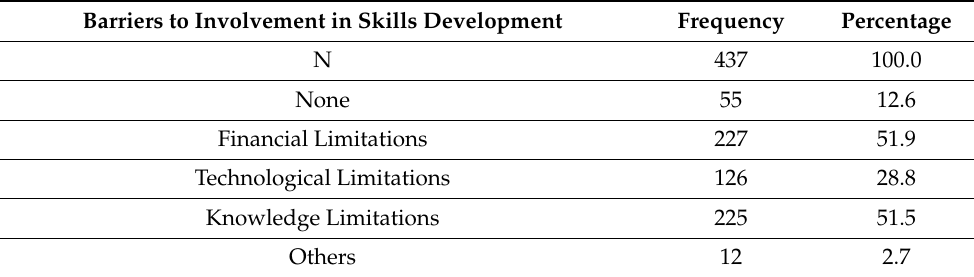
Table 10. Barriers to involvement in skills